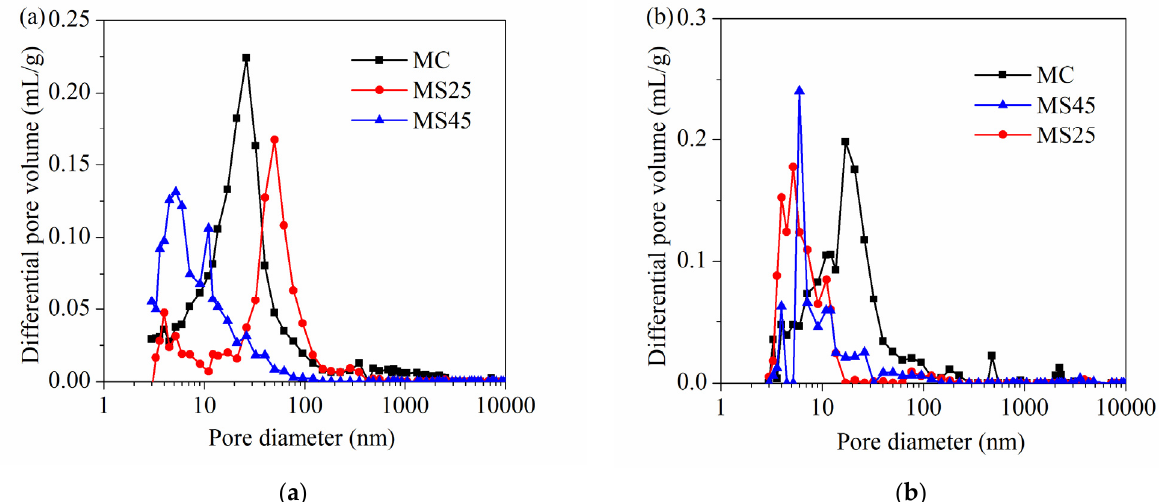
Figure 8. Differential pore volume of hardened pastes under temperature-matching curing conditions: ( a ) at 28 d; ( b ) at 90 d.